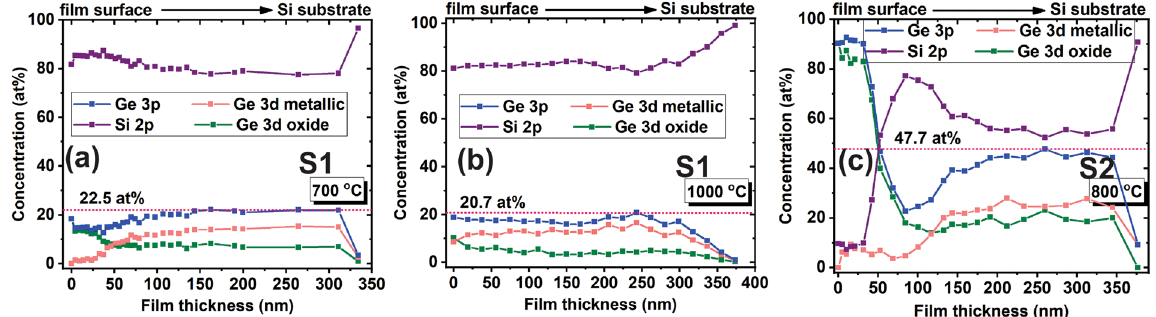
Figure 6. XPS depth profiles of S1 films with 700 °C RTA for 15 min ( a ), 1000 °C RTA for 15 min ( b ) and S2 films with 800 °C RTA for 10 min ( c ). The curves of atomic compositions in function of depth are given for total Ge, total Si, Ge metallic and Ge oxide .